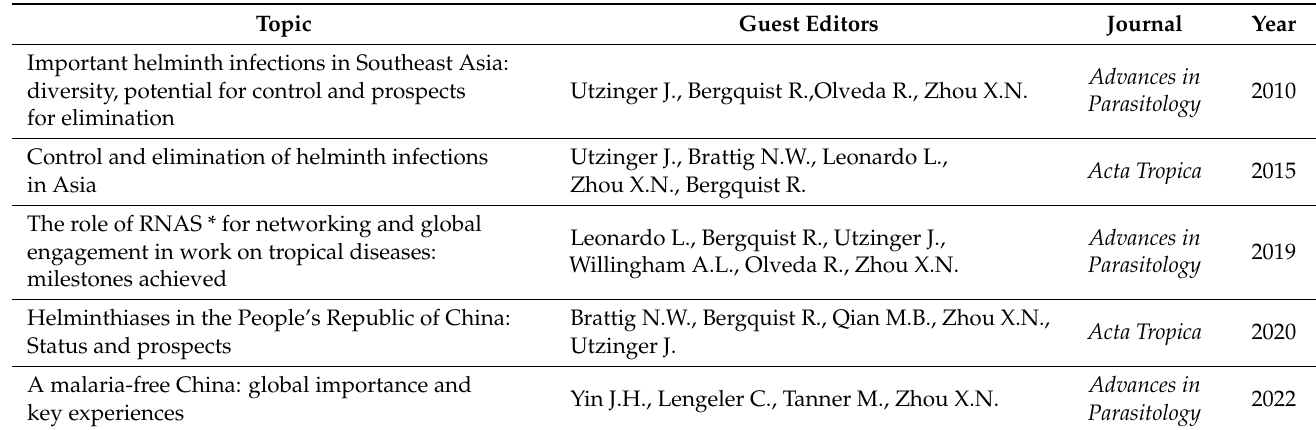
Table 1. Special Issues of journals dealing with tropical diseases published through international cooperation.